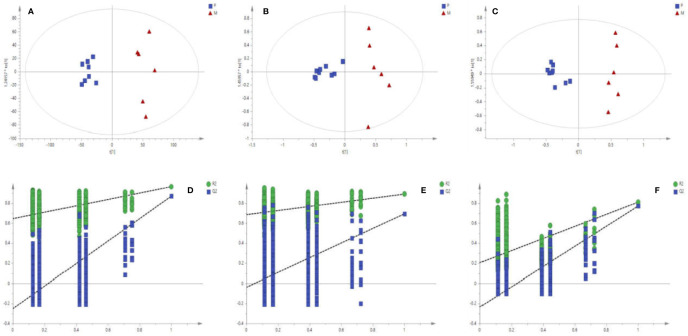
Score plots (A–C) of OPLS-DA Validation plots (D–F) obtained from 999 random permutation tests results between P (square) and M (triangle) in uterine tissues; A, D: GC/MS; B, E: UFLC-IT-TOF/MS (ESI+); C, F: UFLC-IT-TOF/MS (ESI-).